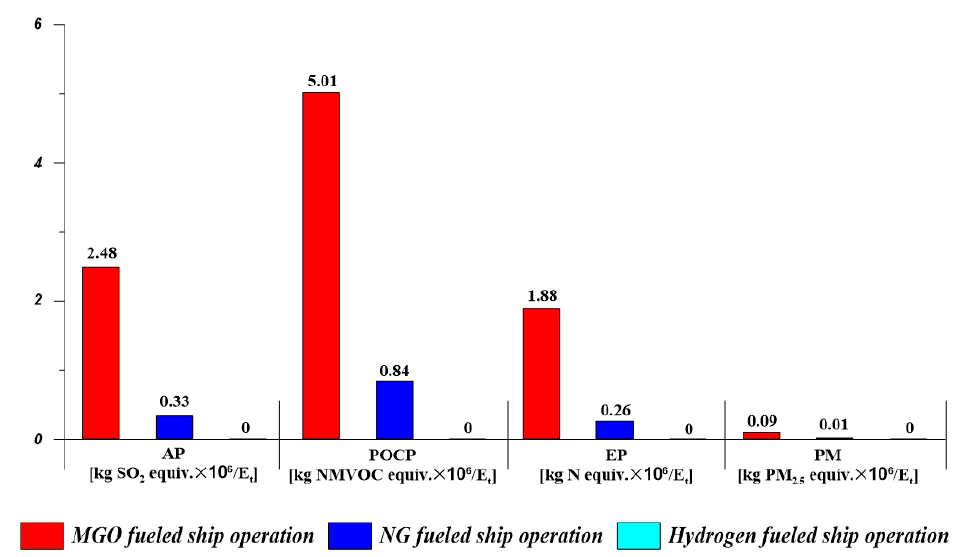
Figure 9. AP, POCP, EP, and PM emissions in the Tank-to-Wake phase.